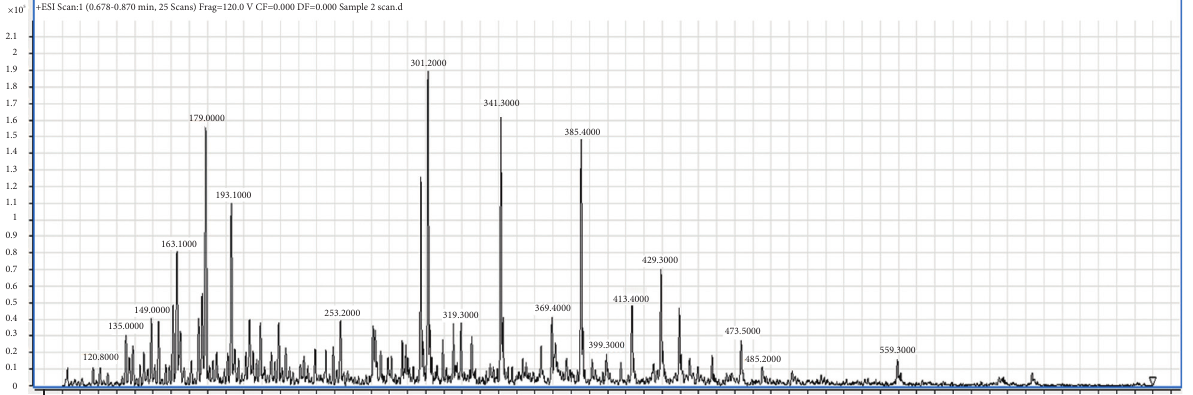
Figure 4: ESI/MS full scan of fraction 4